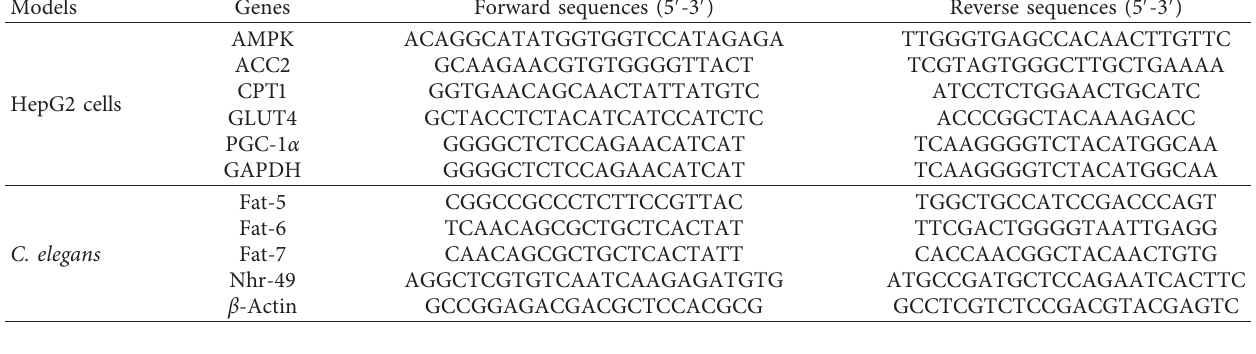
Table 1: Primer sequences for cells and C. elegans